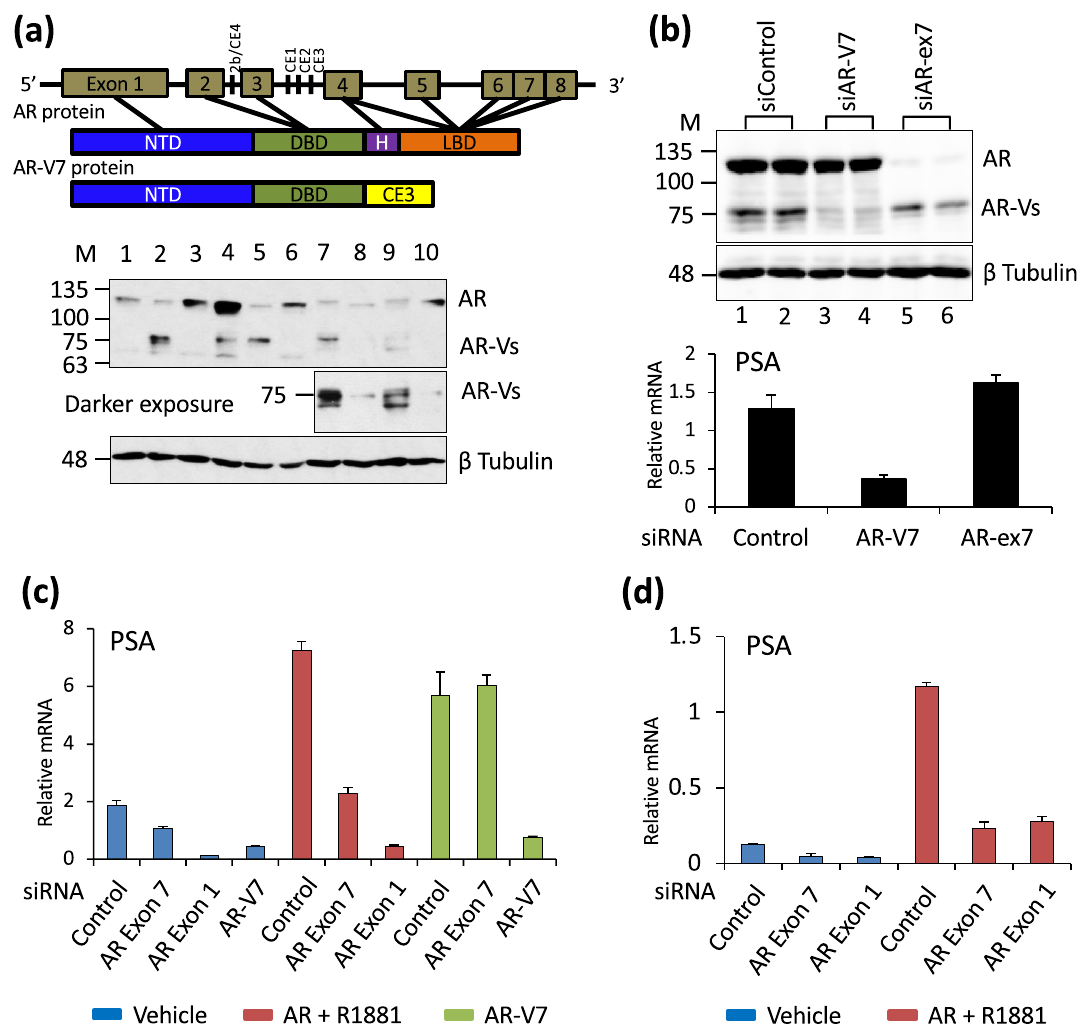
Figure 1. AR-V7 mediated induction of PSA is independent of AR. ( a ) AR exon structure and the corresponding protein domain structures of AR and AR-V7 are shown. Western blot of 20 µg protein from cell lysates of 1. LNCaP cells treated with vehicle (0.1% ethanol), 2. LNCaP-AR-V7 treated with 20 ng/mL Dox, 3. LNCaP cells treated with 10 nM R1881 (a synthetic androgen), 4. VCaP cells treated with vehicle, 5. VCaP-V7 treated with 100 ng/mL Dox, 6. VCaP treated with 10 nM R1881, 7. 22RV1 cells treated with vehicle, 8. LN95 cells treated with vehicle, 9. 22RV1 cells treated with 10 nM R1881, 10. LN95 cells treated with 10 nM R1881. AR isoforms were detected with AR441 mAb, which recognizes AR isoforms that contain exon 1. ( b ) Western blot confirmation of siRNA knock-down in LN95 cells treated with control siRNA (lanes 1,2), siRNA targeting AR-V7 (lanes 3,4) and exon-7 siRNA targeting AR (lanes 5,6) for 48 h in charcoal stripped serum (CSS). RNA was isolated from parallel samples and PSA measured by qPCR and normalized to 18S RNA. ( c ) LNCaP AR-V7 cells in CSS were treated with the indicated siRNAs for 48 h followed by treatment with vehicle, R1881, or Dox overnight. RNA was isolated, PSA expression measured by qPCR and normalized to 18S RNA. ( d ) LNCaP cells in CSS were treated with the indicated siRNAs for 48 h followed by overnight treatment with vehicle or R1881. RNA was isolated and PSA measured as above. All qPCR data are plotted as a mean of three biological replicates from the same experiment and error bars are SEM. Each experiment was performed a minimum of three times and a representative experiment is